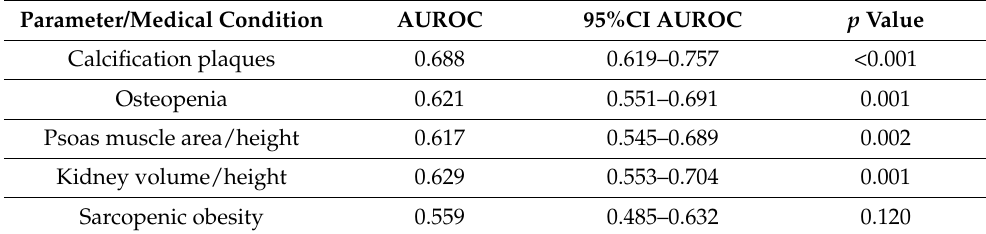
Table 6. ROC curves for major complications.